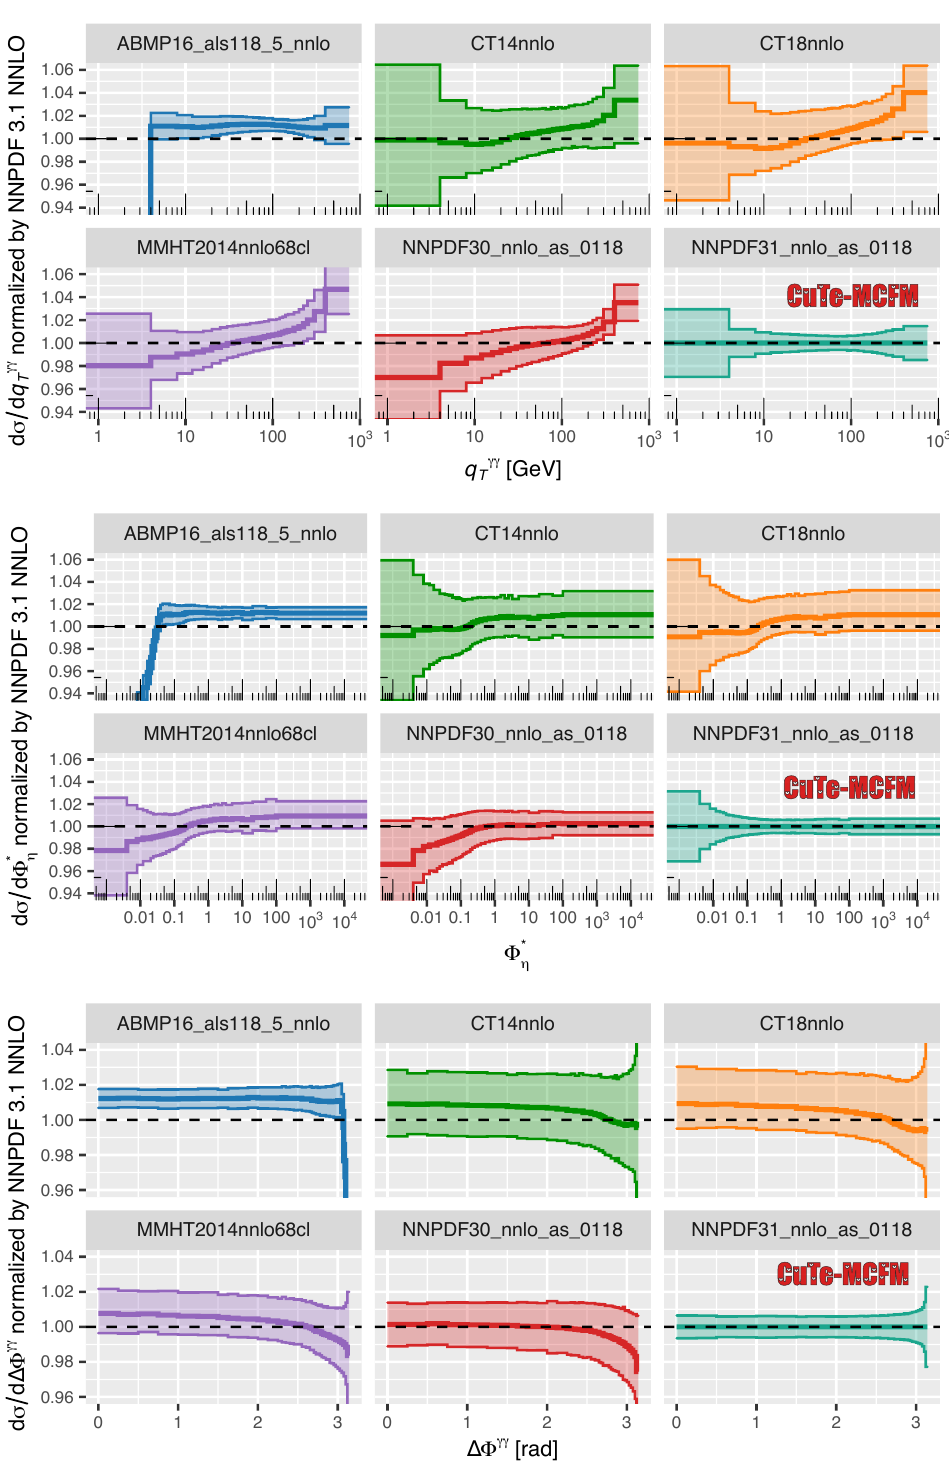
Figure 25. PDF uncertainties for the q T , φ ∗ and ∆ φ distributions in figures 18, 19 and 20. The ABMP16 set is not defined below µ = 4 . 47 GeV , which can be seen as breakdown in the